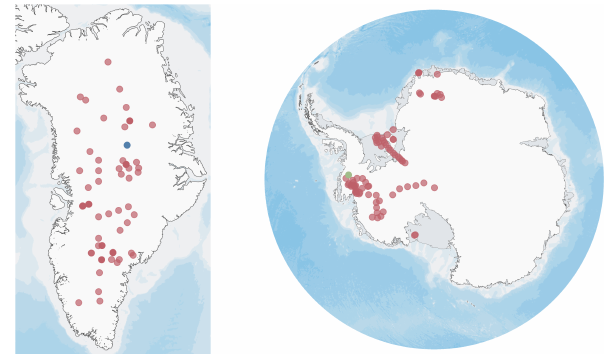
Figure 2. Locations of firn profiles used for model comparison. Eighty profiles were measured in Greenland, and 79 depth den- sity datasets were retrieved in Antarctica. The blue marker shows the location of ice core ngt03C93.2 (Wilhelms, 2000, 73.940 ◦ N, − 37 . 630 ◦ E). The green marker shows the location of site 3 of the iSTAR traverse, from which the firn core shown in Fig. 3 was re- trieved (Morris et al., 2017, − 74 . 565 ◦ N, − 86 . 913 ◦ E). Map data: Amante and Eakins (2009) and Arndt et al. (2013), SCAR Antarctic Digital